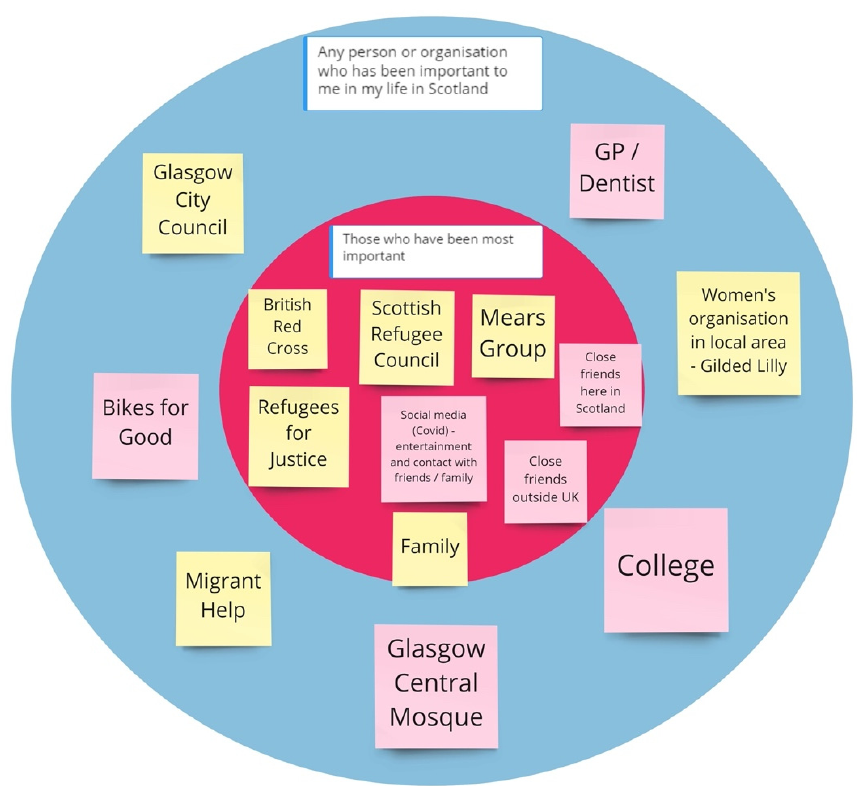
Figure 1. Bullseye map created with Miro Whiteboard Tool.